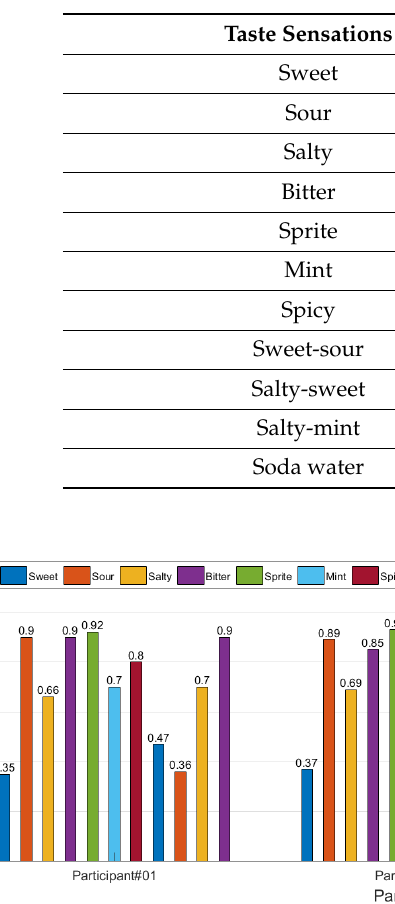
Figure 6. Mean value of taste sensations of 3 participants with highly sensitive taste buds.